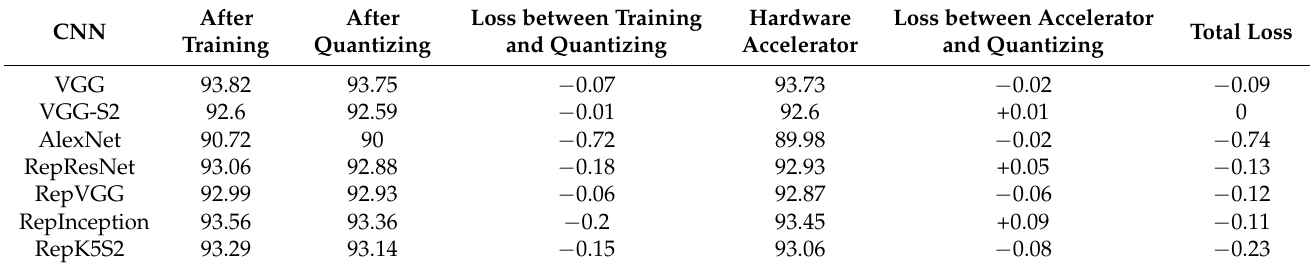
Table 3. Accuracy of seven CNNs after training, quantization, and hardware